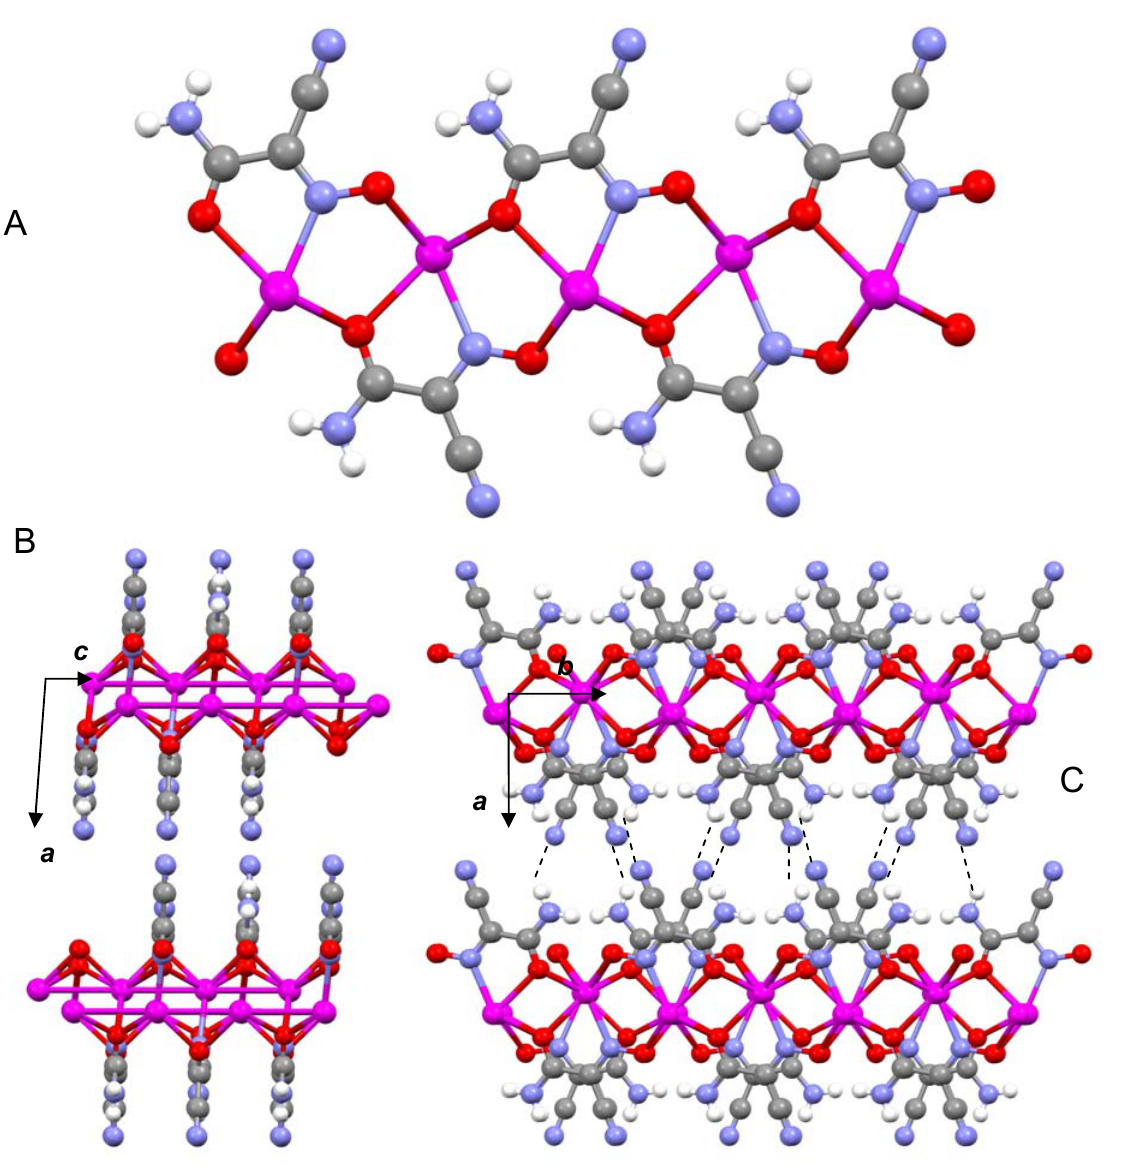
Figure 14. Organization of 2D, layered polymeric structure of Ag(ACO): one layer of “head-to-tail” packed molecules of the complex ( A ) and two views of multiple unit cells along a ( B ), and b directions ( C ) showing H-bonding (dashed lines) between